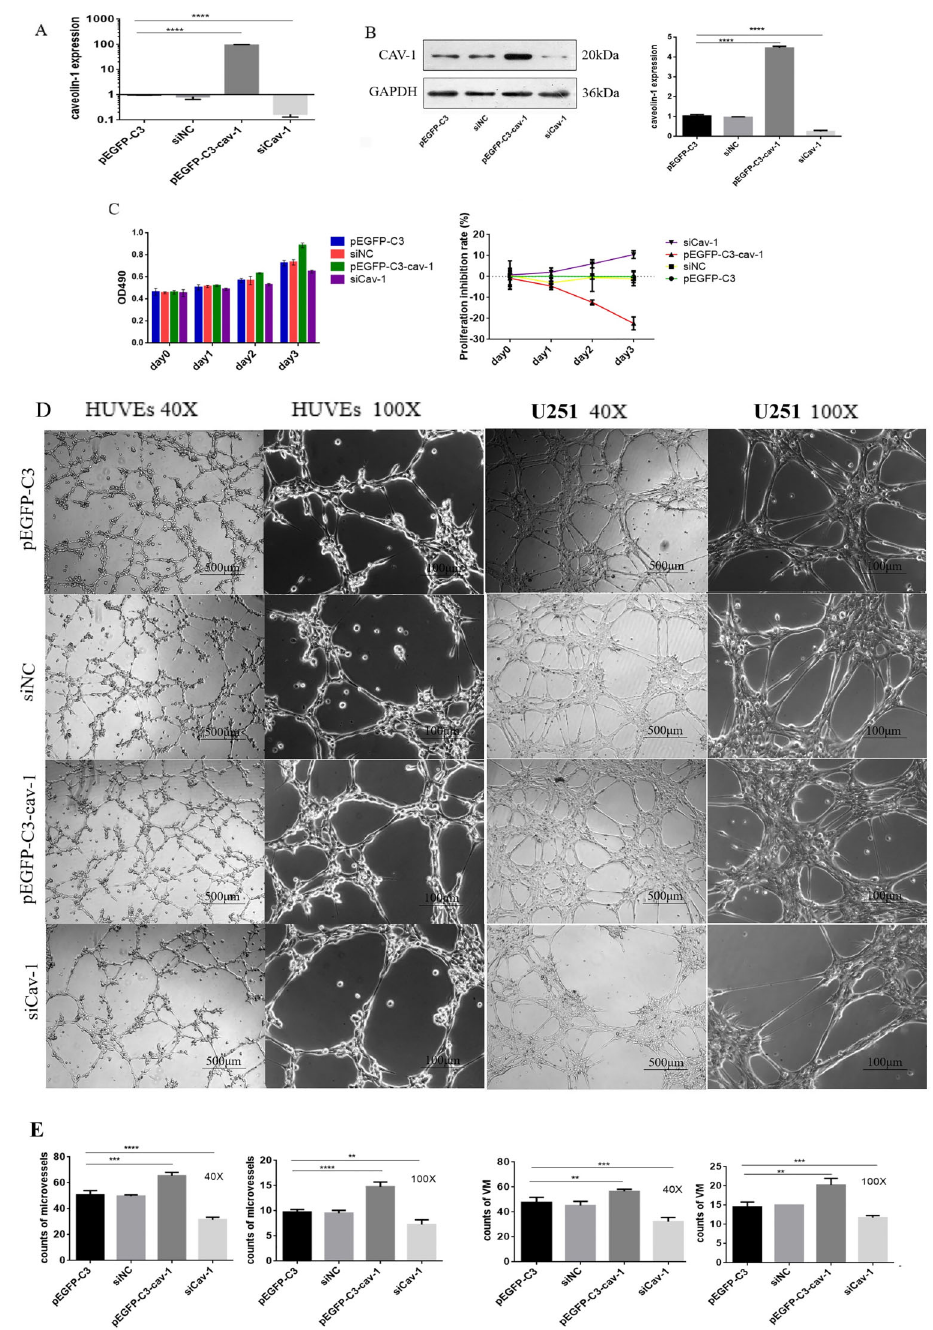
Figure 3. Cav-1 promotes U251 glioma cell proliferation in vitro . U251 cells were transfected with empty vector pEGFP-C3 or the vectors expressing Cav-1, siCav-1, or negative control siRNA (siNC). The transfection ef fi ciency was con fi rmed by qPCR ( A ) and western blot analysis ( B ). C , Cell proliferation was measured at time points as indicated using the CCK-8 assay. D , Human umbilical vein endothelial cells (HUVECs) and U251 glioma cells were transfected with pEGFP-C3, pEGFP-C3-Cav-1, siCav-1, or siNC and veri fi ed by enhanced chemiluminescence assay. Images were captured at magni fi cation 40 (scale bar 500 m m) and 100 (cid:1) (scale bar 100 m m). Representative images are shown. E , Branch points in 3 randomly selected fi elds were counted using ImageJ software. Data are reported as means ± SE. **P o 0.01, ***P o 0.001, ****P o 0.0001 vs other groups (transfected with pEGFP-C3, siCav-1, or siNC; ANOVA) for n=3. NC: negative